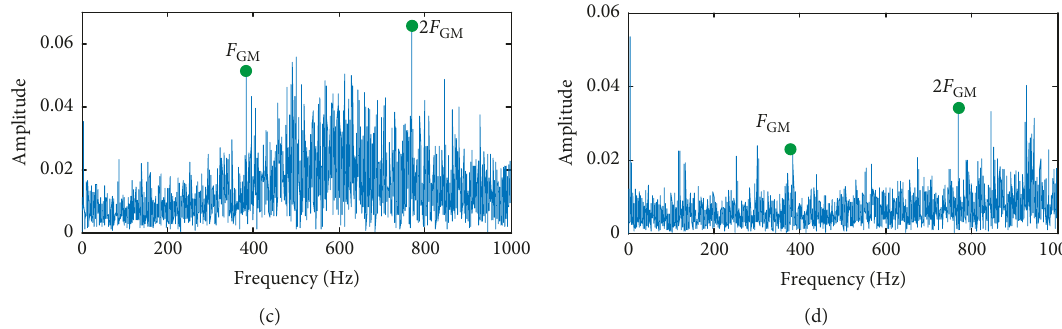
Figure 26: The frequency domain diagram of the signals in Figure 25, where F